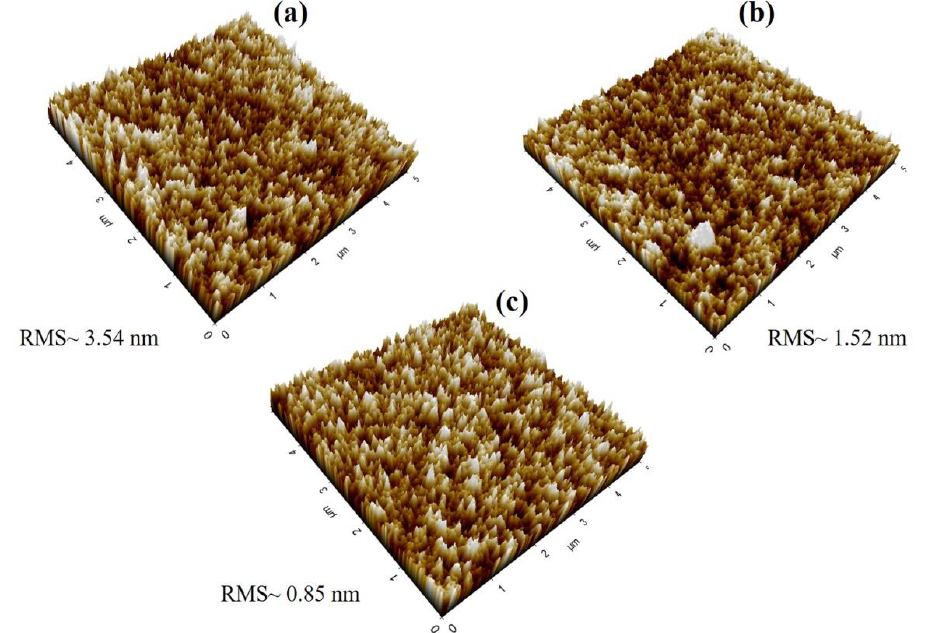
Figure 6. AFM images of ITO/PEDOT:PSS (or GO)/(FeS 2 SNPs + PBT7) films with- and without- electron transport layer (ETL): ( a ) without-ETL, ( b ) with-ZnO, and ( c ) with-ZnO/PEO.